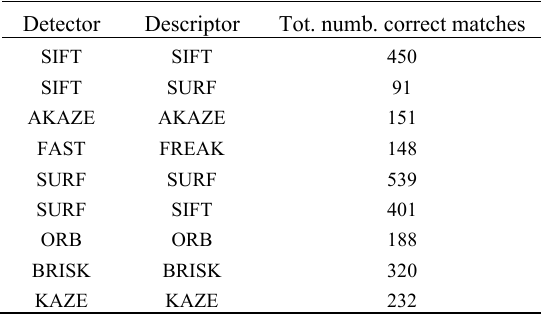
Table 2: Various combinations of detectors/descriptors for the terrestrial dataset of Figure